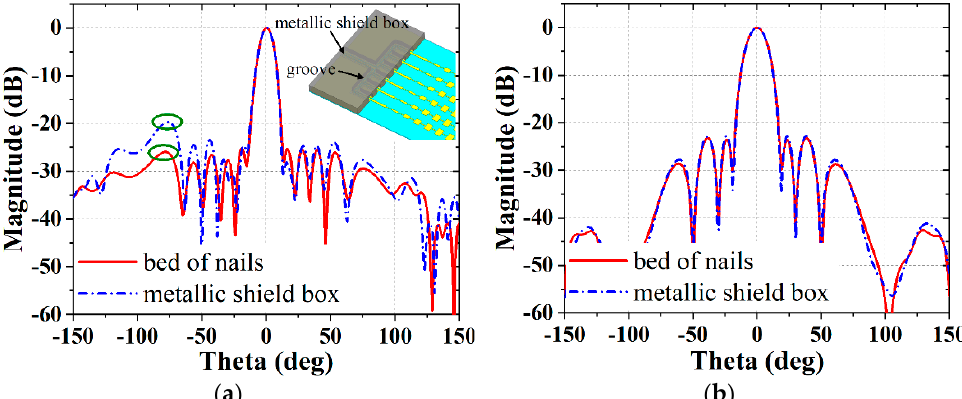
Figure 13. The radiation pattern with and without the bed of nails. ( a ) E − plane. ( b ) H − plane.